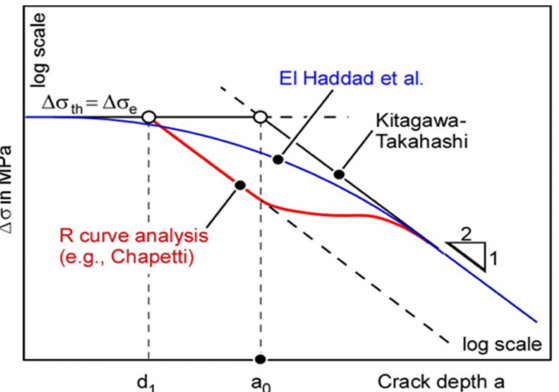
Figure 12. Schematic view of the discrepancy between the conventionally and by means of cyclic R curve analysis obtained KT